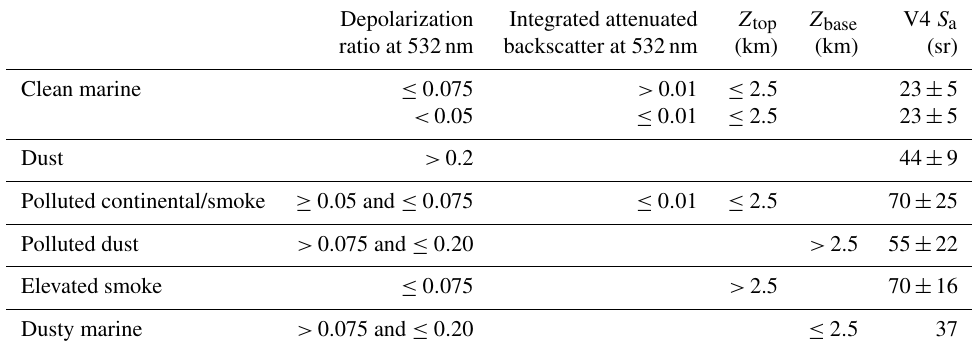
Table 1. Classification criteria for tropospheric aerosols in CALIOP V4 over the ocean. Depolarization Integrated attenuated Z top Z base V4 S a ratio at 532nm backscatter at 532nm (km) (km) (sr) Clean marine ≤ 0 . 075 > 0.01 Dust > 0.2 ≥ 0 . 05 and ≤ 0 .